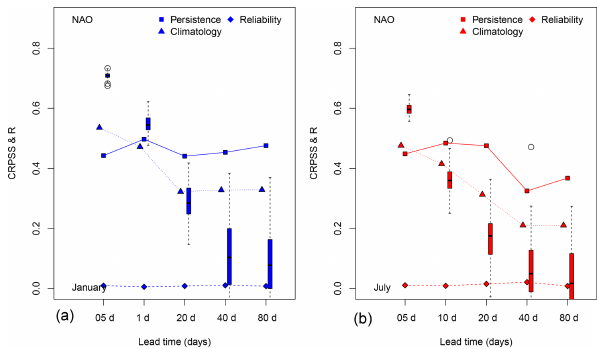
Figure 5. Skill scores for the NAO index for lead times T of 5, 10, 20, 40, and 80 days for January ( a : blue) and July ( b : red). Squares indicate CRPSS pers , triangles CRPSS clim , and boxplots correlation. The diamonds indicate the reliability of CRPS (on the same scale as CRPSS). Triangles are identical for all days, January and July. The boxplots for the correlation indicate the spread across the 100- member ensemble